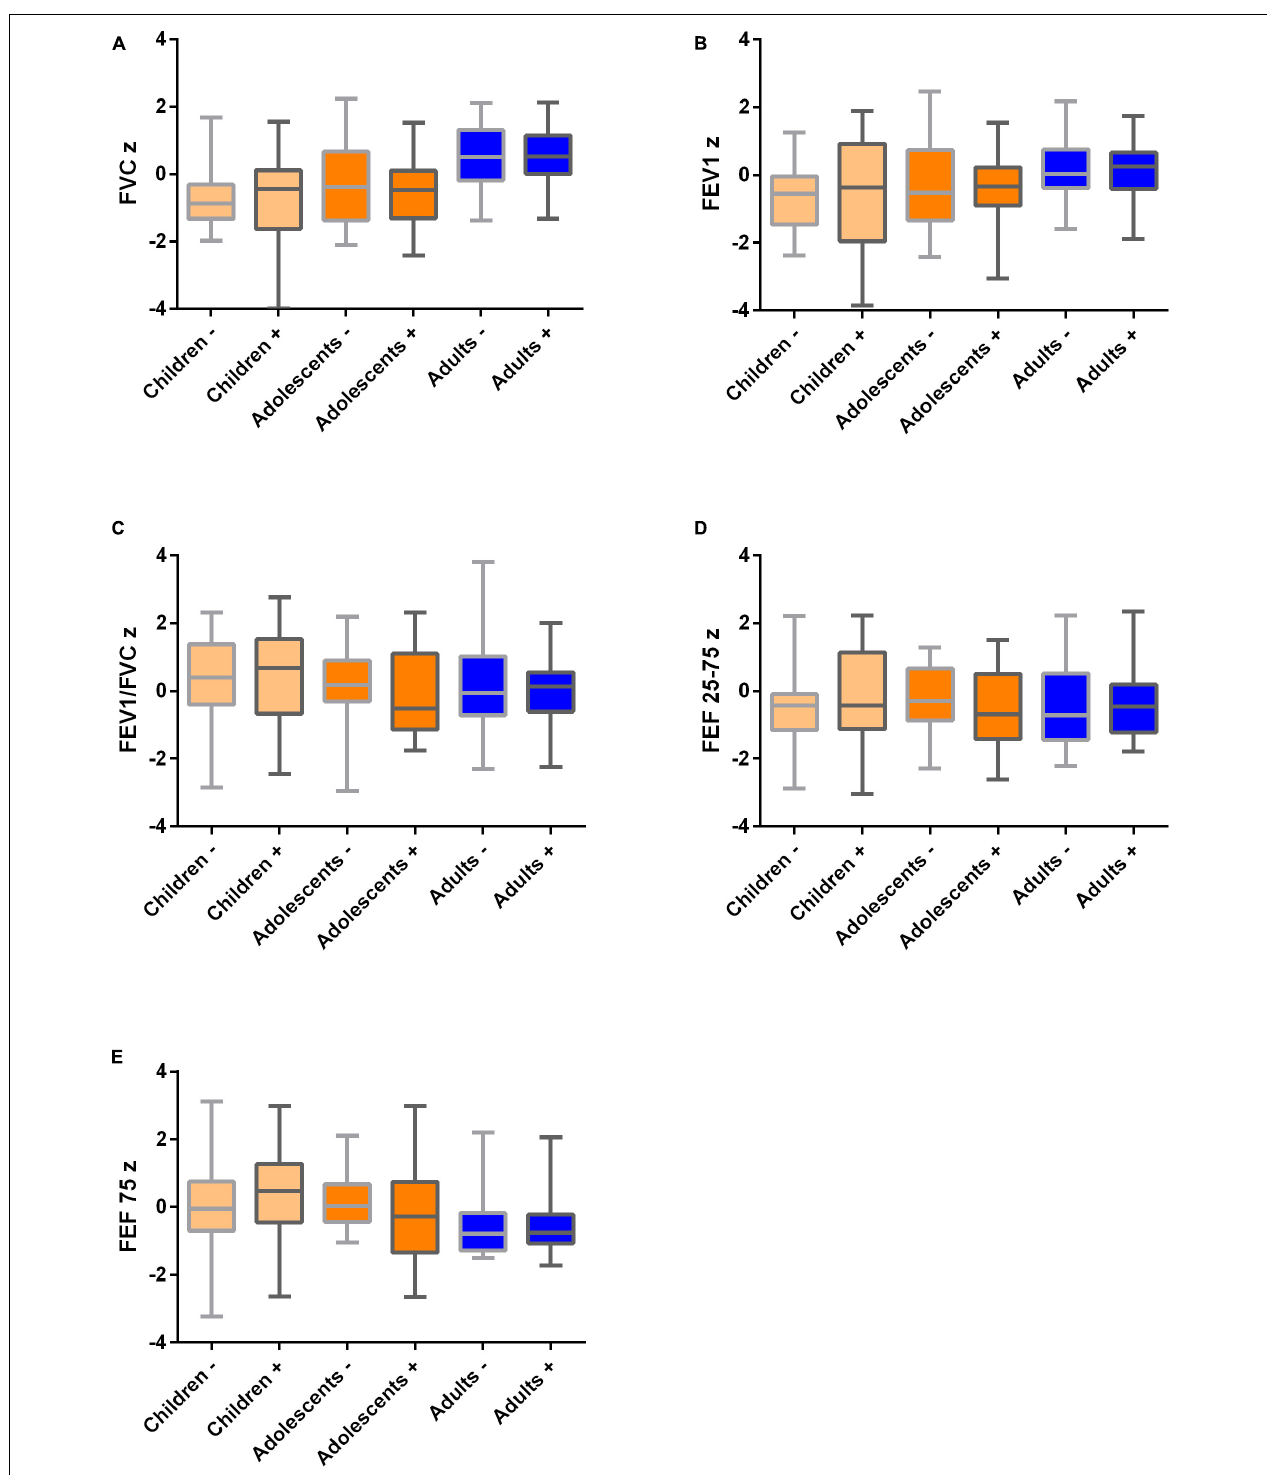
FIGURE 1 | Spirometry values in children ( n = 53), adolescents and young adults ( n = 34) and their parents ( n = 95) 12 months after mild SARS-CoV-2 infection in n = 25/15/68 participants, respectively, and healthy family members as controls. SARS-CoV-2 negative (-) vs. positive (+) participants are visualized. All medians are in the normal range. Boxplots (medians, quartiles, minimum and maximum values) for normalized (z scores) spirometry parameters. (A) FVCz, (B) FEV1z, (C) FEV1z/FVCz, (D) FEF 25–75z, and (E) FEF 75z. FVC, forced vital capacity; FEV1, forced expiratory volume in 1 s; FEF25 75, mean flow between 25% and 75% of the forced vital capacity; FEF75, maximum expiratory flow at 75% expiration of forced vital capacity. Children 4–14 years, adolescents 14–25 years, adults > 25 years.